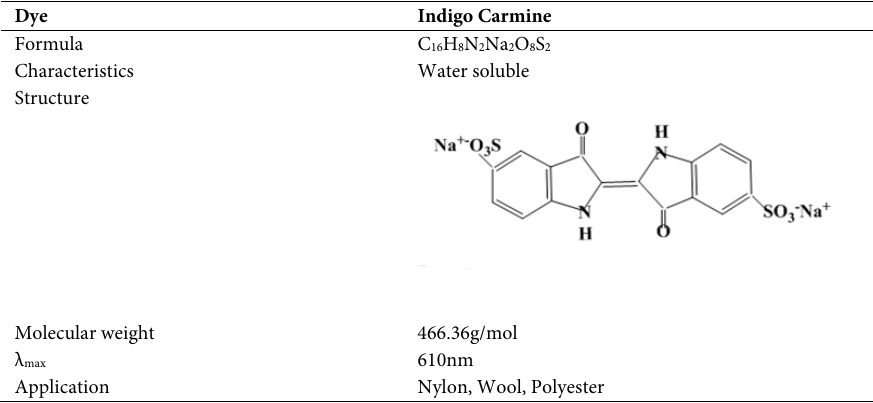
Table 1. Molecular Structure and Chemical properties of Indigo Carmine